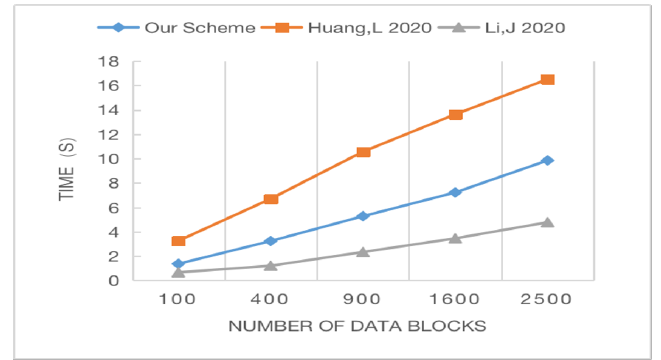
Figure 3. Computational cost for SignGen